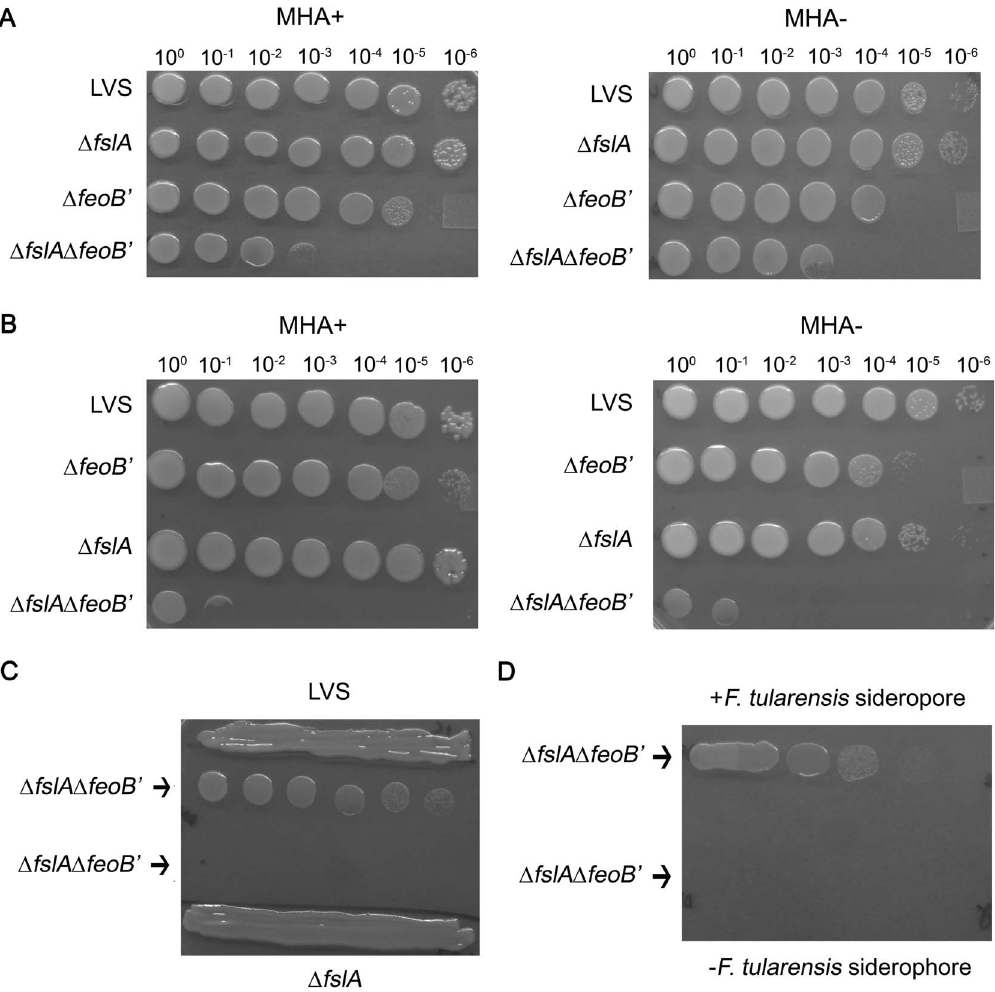
Figure 5. The D fslA D feoB 9 strain requires F.tularensis siderophore for growth. A and B, LVS, D fslA , D feoB 9 , and D fslA D feoB 9 strains grown on MHA + agar plates were resuspended and brought to an OD 600 of 1 in che-CDM. Strains were further serially diluted and spotted on MHA + and MHA- plates. The order of D fslA and D feoB 9 spots was switched in A and B. C, ten-fold serial dilutions of the mutant D fslA D feoB 9 were spotted near dense streaks of LVS or D fslA strains on an MHA + plate and grown for two days under aerobic 37 u C conditions. D, ten-fold serial dilutions of the D fslA D feoB 9 strain were spotted with (top) or without (bottom) 5 m L of 1.5 mM F. tularensis siderophore and grown for two days under aerobic 37 u C conditions.